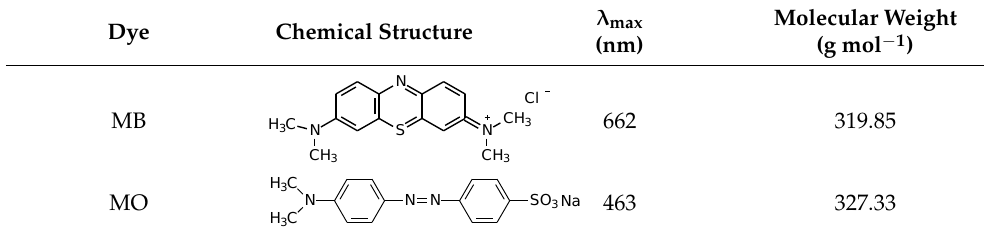
Table 1. Structure and characteristics of MB and MO dyes.